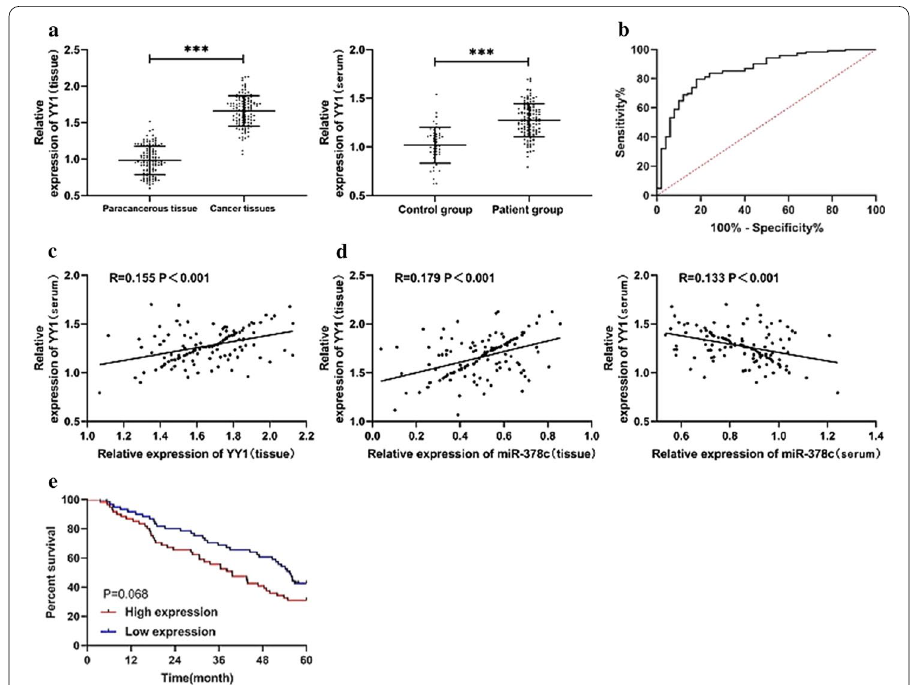
Fig. 3 Expression of YY1 in patients with gastric cancer. a Relative expression of YY1 in gastric cancer tissues and serum. b ROC curve of YY1 in diagnosis of gastric cancer. c Correlation analysis of YY1 in tissues and serum of patients with gastric cancer. d Correlation analysis of relative expression of miR-378c and YY1 in cancer tissue and serum of patients with gastric cancer. E: Relationship between YY1 and survival of patients with gastric cancer. ***P < 0.001. R r 2 =